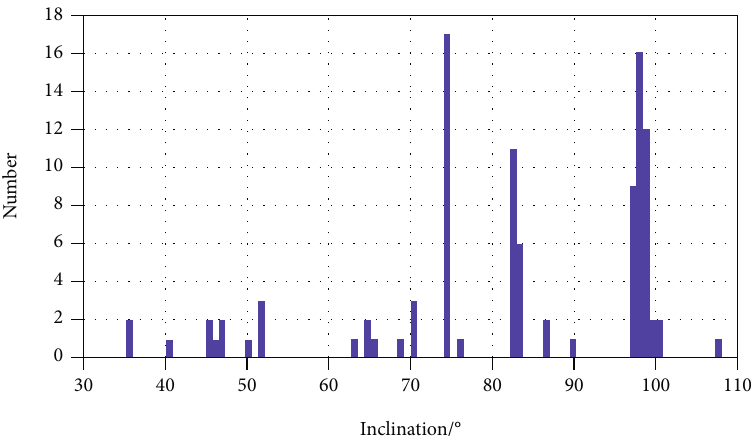
Figure 2: Histogram of the inclinations of the piggyback